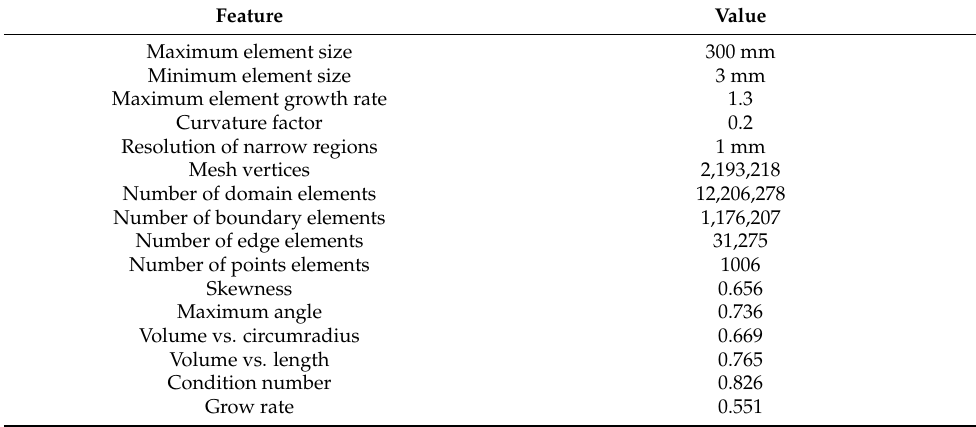
Table 4. Average mesh statistics of FEM models